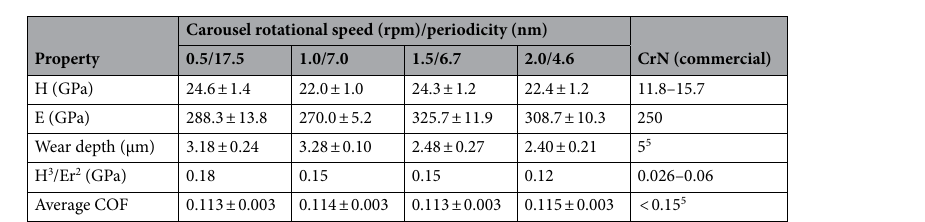
Table 2. Summary of H, E, wear against the cylinder liner, and H 3 /Er 2 values obtained for CrN/Cr 1-x Al x N multilayers manufactured at a constant bias of − 150 V and different rotational speeds of the carrousel. The data of commercial CrN is included for comparison.